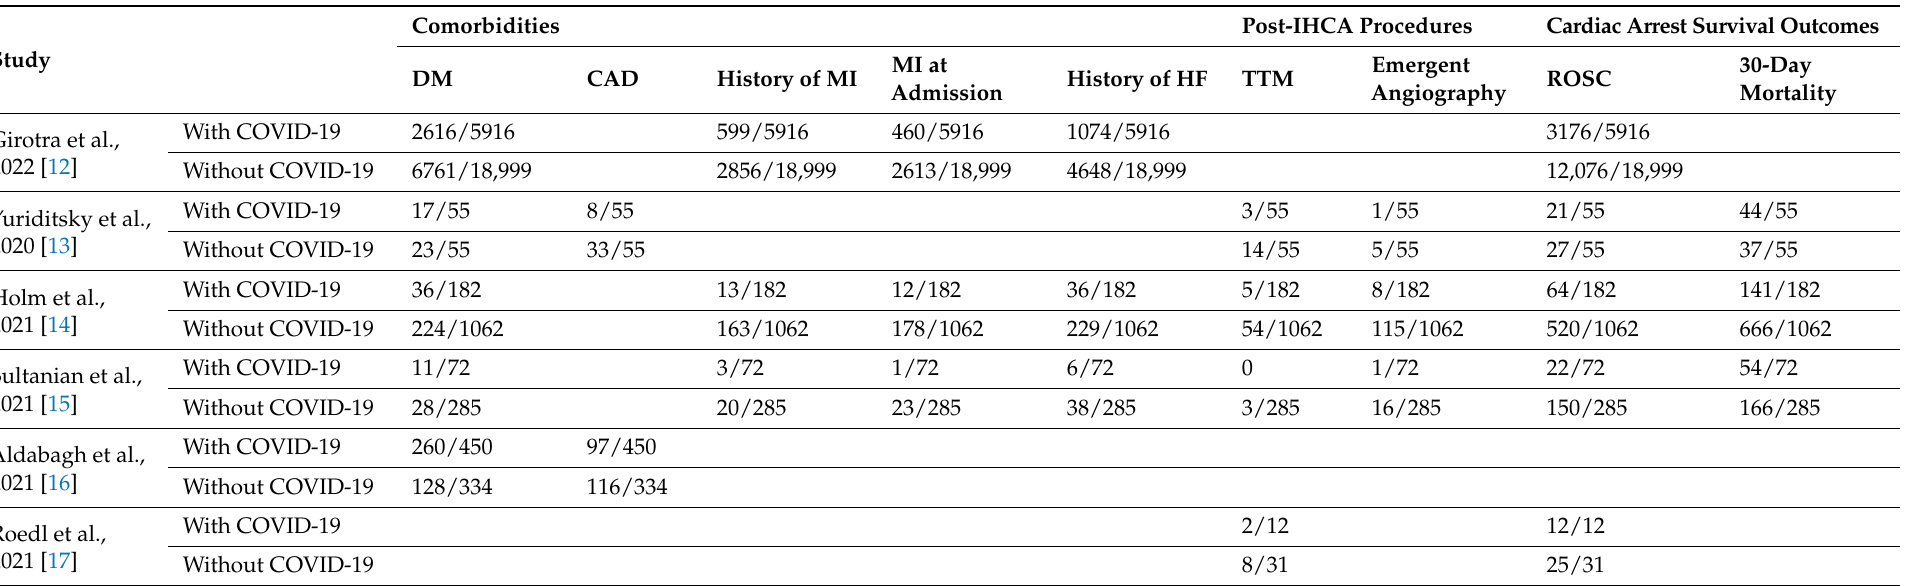
Table 3. Comorbidities and outcome of included